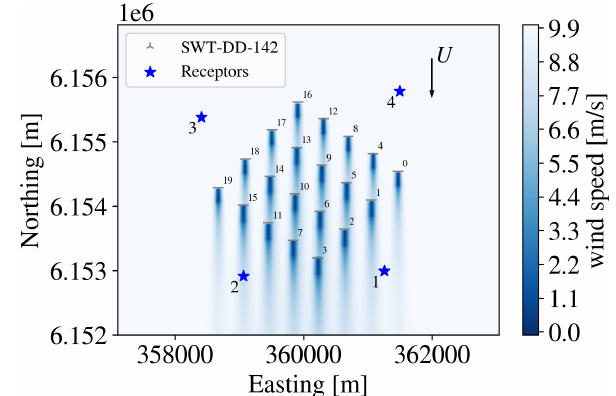
Figure 15. Example of flow at hub height through the 4 × 5 SWT- DD-142 wind turbines at the wind direction θ = 0 ◦ . The distances between the turbines are scaled to be approximately 4.3 and 3.3 D